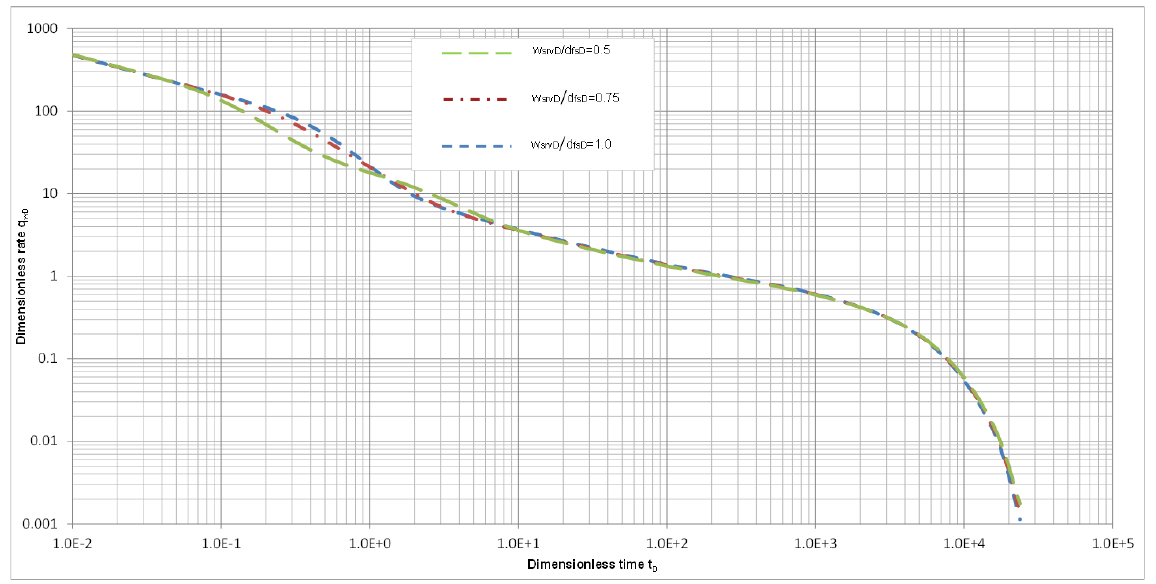
Figure 21. Pressure response of a fractured, horizontal well under a different ratio of local SRV width and space between fractures as 𝑘 1 /𝑘 2 = 20 , 2𝐿 𝑓𝐷 /𝑌 𝑒𝐷 = 0.1 , 𝑋 𝑒𝐷 = 200 , and 𝑌 𝑒𝐷 = 100 .